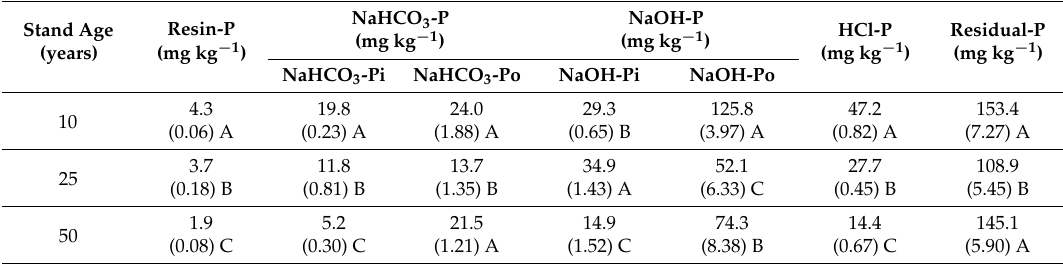
Values in the table are the means (standard errors) of the three plots per stand n = 3. Pi: inorganic P; Po: organic P. Different letters indicate groups with significant differences between different stand ages in each soil P fraction ( p < 0.05).